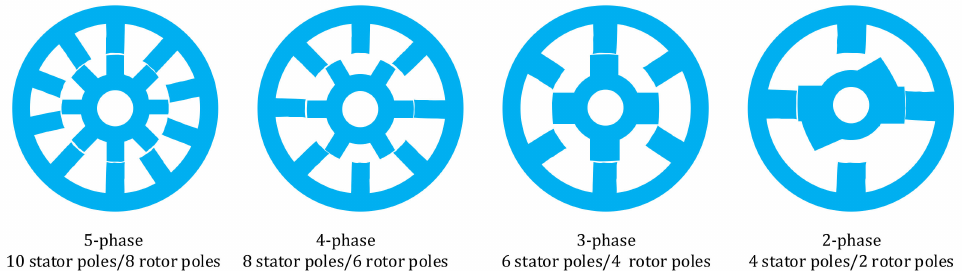
Figure 1. Conventional SRMs with different numbers of stator and rotor poles